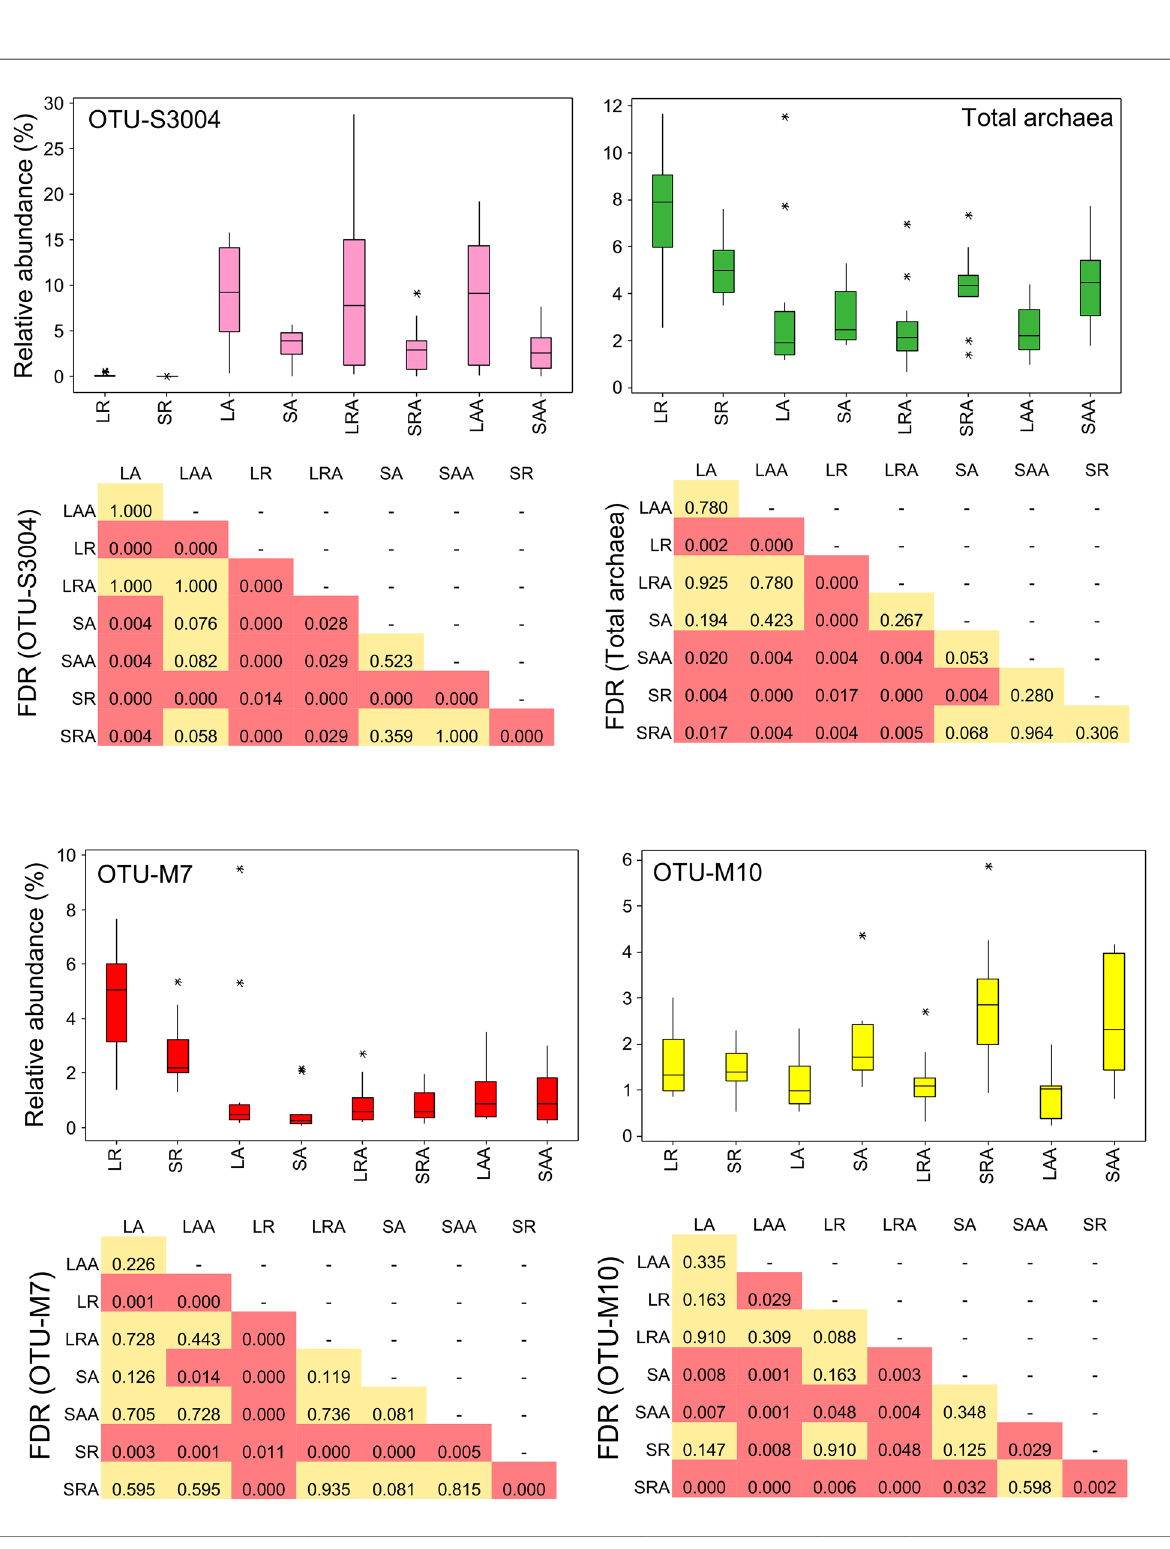
PLOS ONE | DOI:10.1371/journal.pone.0133234 July 30,